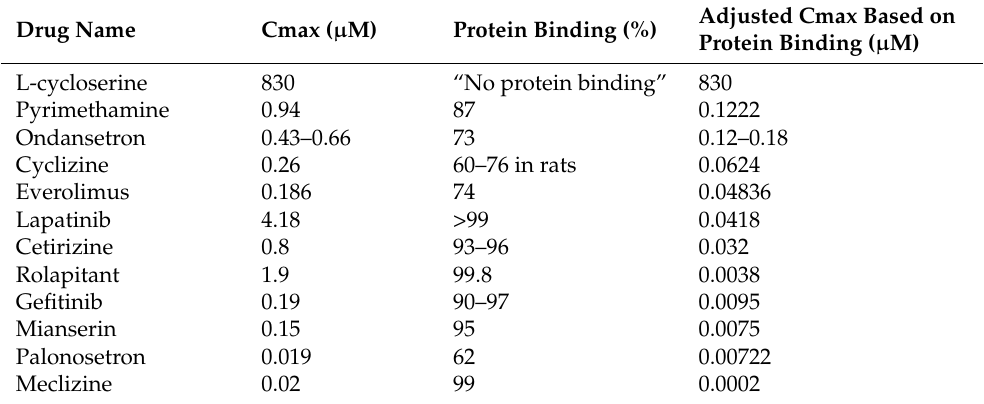
Table 4. Final prioritisation of drugs for repurposing based on adjusted Cmax